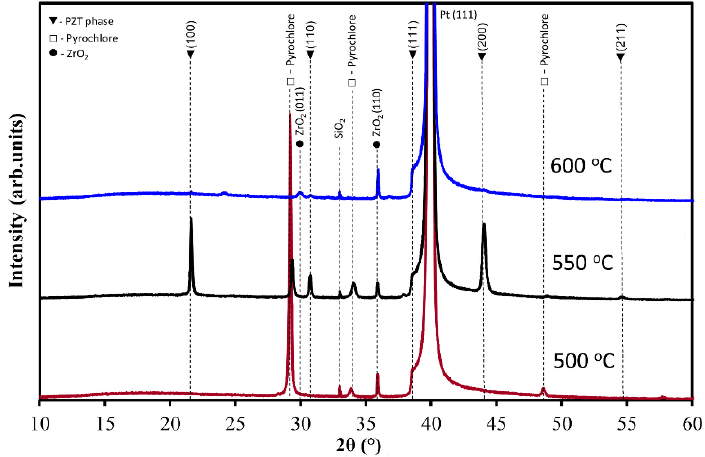
Figure 2. XRD patterns of PZT films deposited at 500, 550, and 600 °C substrate temperature.